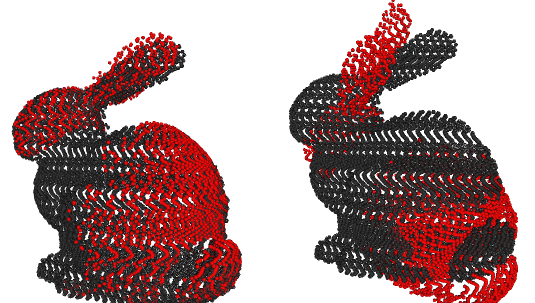
90 ◦ : (a) Registration obtained with Sparse Fig. 8: Case 45 ◦ − ICP CTSF using k = 5% . (b) Final alignment generated by Sparse ICP.